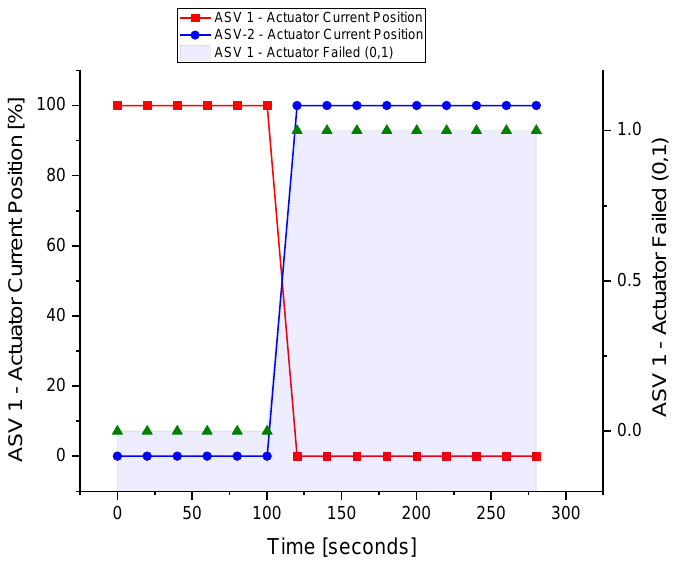
Figure 19. The fault tolerance in the actuator.